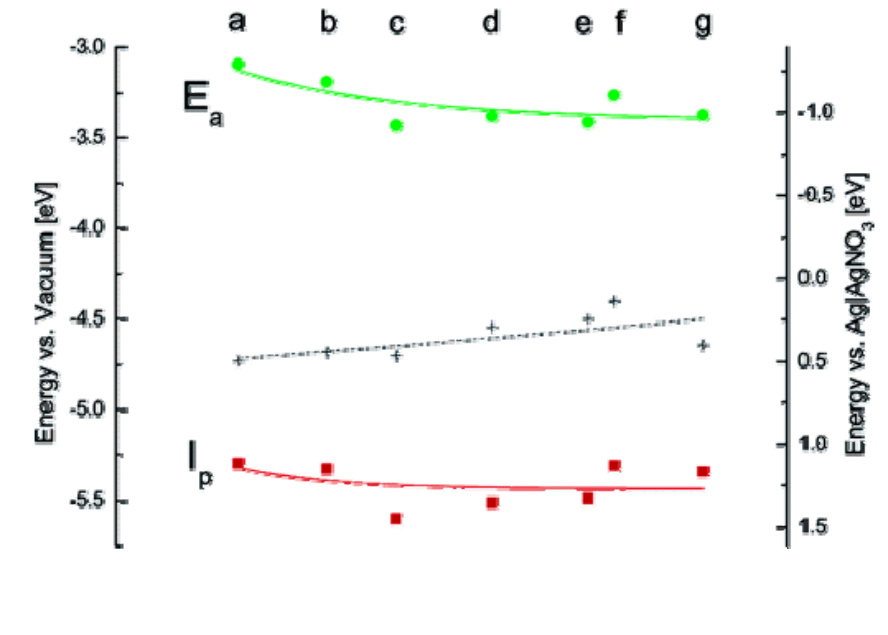
Figure 9. Experimental values of ionization potential (I different sized TOPO coated CdSe Qdots (a: 2.3 nm, b: 3.1 nm, c: 3.2 nm, d: 3.5 nm, e: 3.7 nm, f: 3.8 nm, g: 4.0 nm) (Reprinted with permission from [62]. Copyright 2005 American Chemical